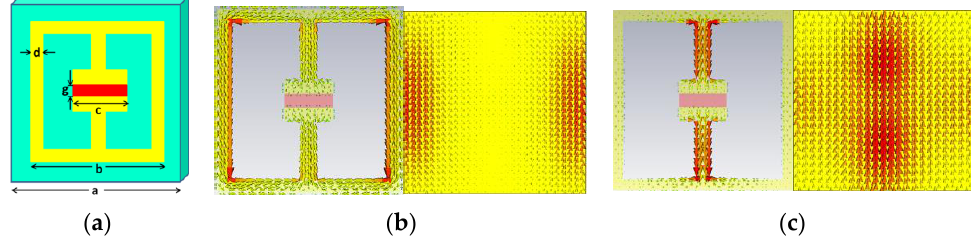
Figure 9. ( a ) The unit cell of the metamaterial absorber structure ， where, a, b, c, d and g represent symbols of geometric dimensions. The simulated surface current density for ( b ) the low-frequency absorption without illumination ( c ) the higher-frequency resonance for σ si = 2000 S/m. Figure reproduced with permission [7].